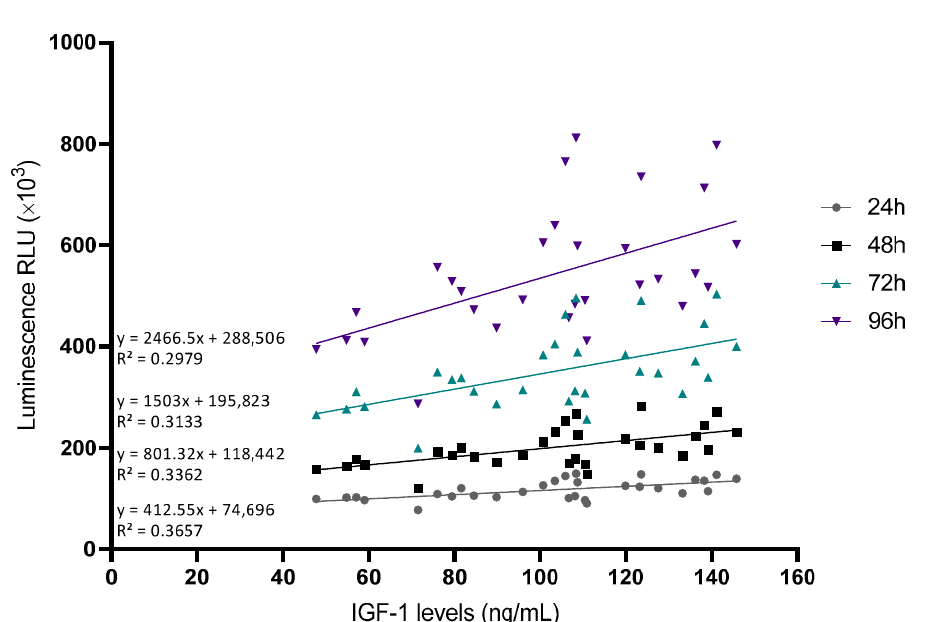
Figure 5. Correlations between IGF-1 levels and cellular viability at different time points. Cell viability was measured at different time points and the RLU was correlated with IGF-1 levels measured by ELISA ( n = 30).